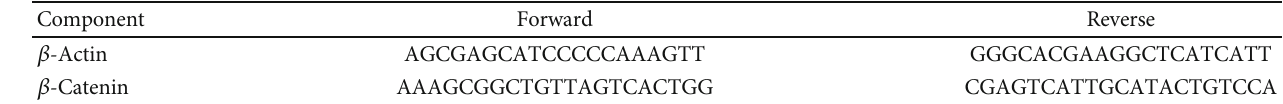
Table 2: The primers that were utilized are listed.